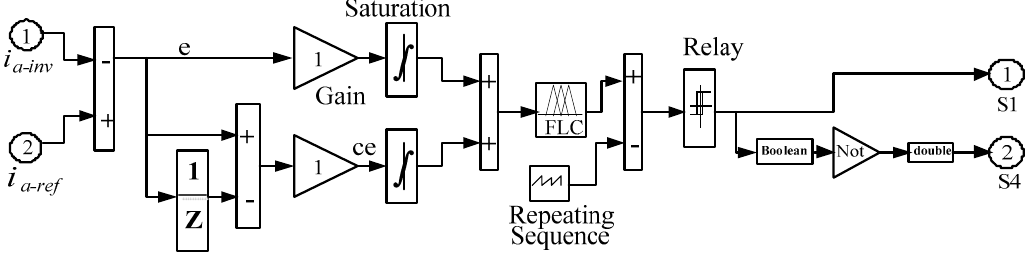
Figure 6. Fuzzy logic based current control scheme for generating switching pulses.